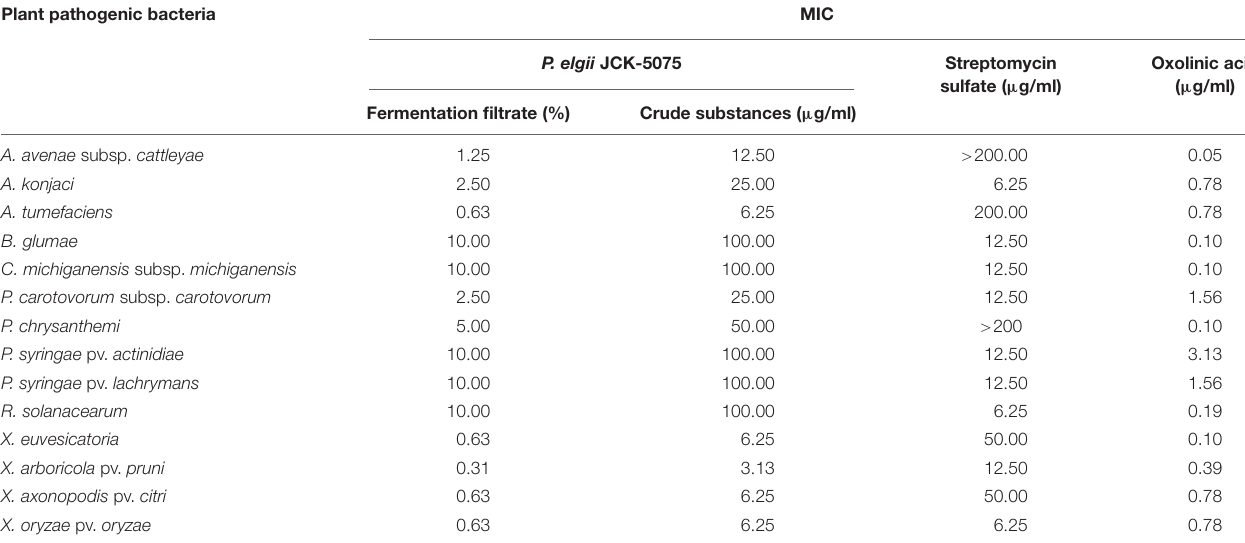
TABLE 1 | Minimum inhibitory concentration (MIC) of the fermentation filtrate and the ethanol crude substances of Paenibacillus elgii JCK-5075 against 14 plant pathogenic bacteria. Plant pathogenic bacteria